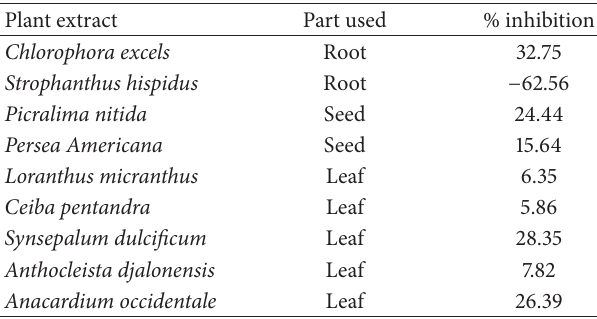
Table 3: Percentage 𝛼 -amylase inhibition of the selected antidia- betic